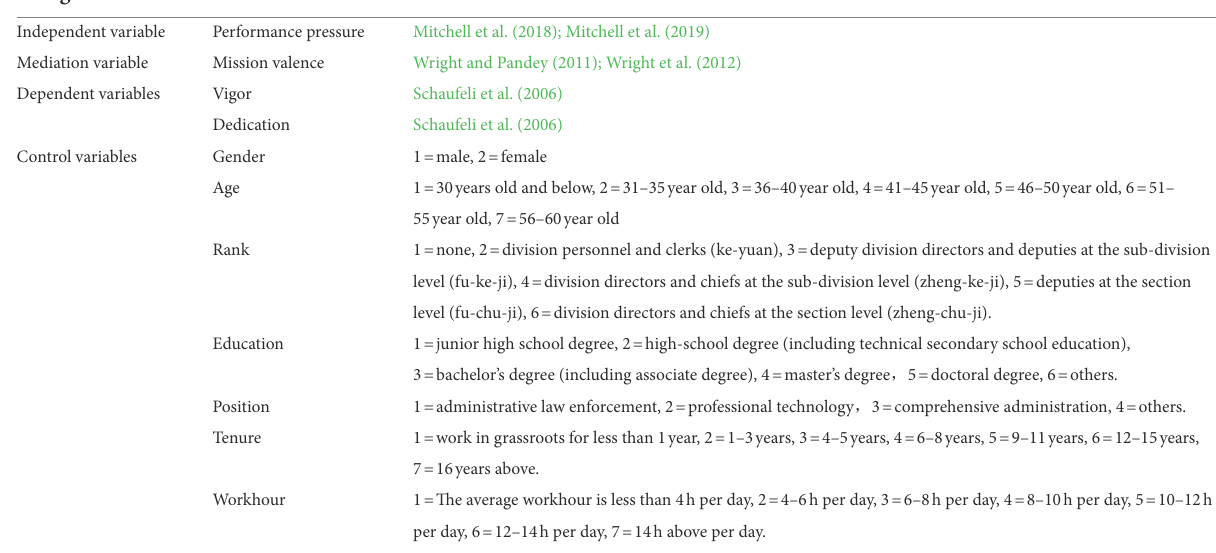
TABLE 1 Description of